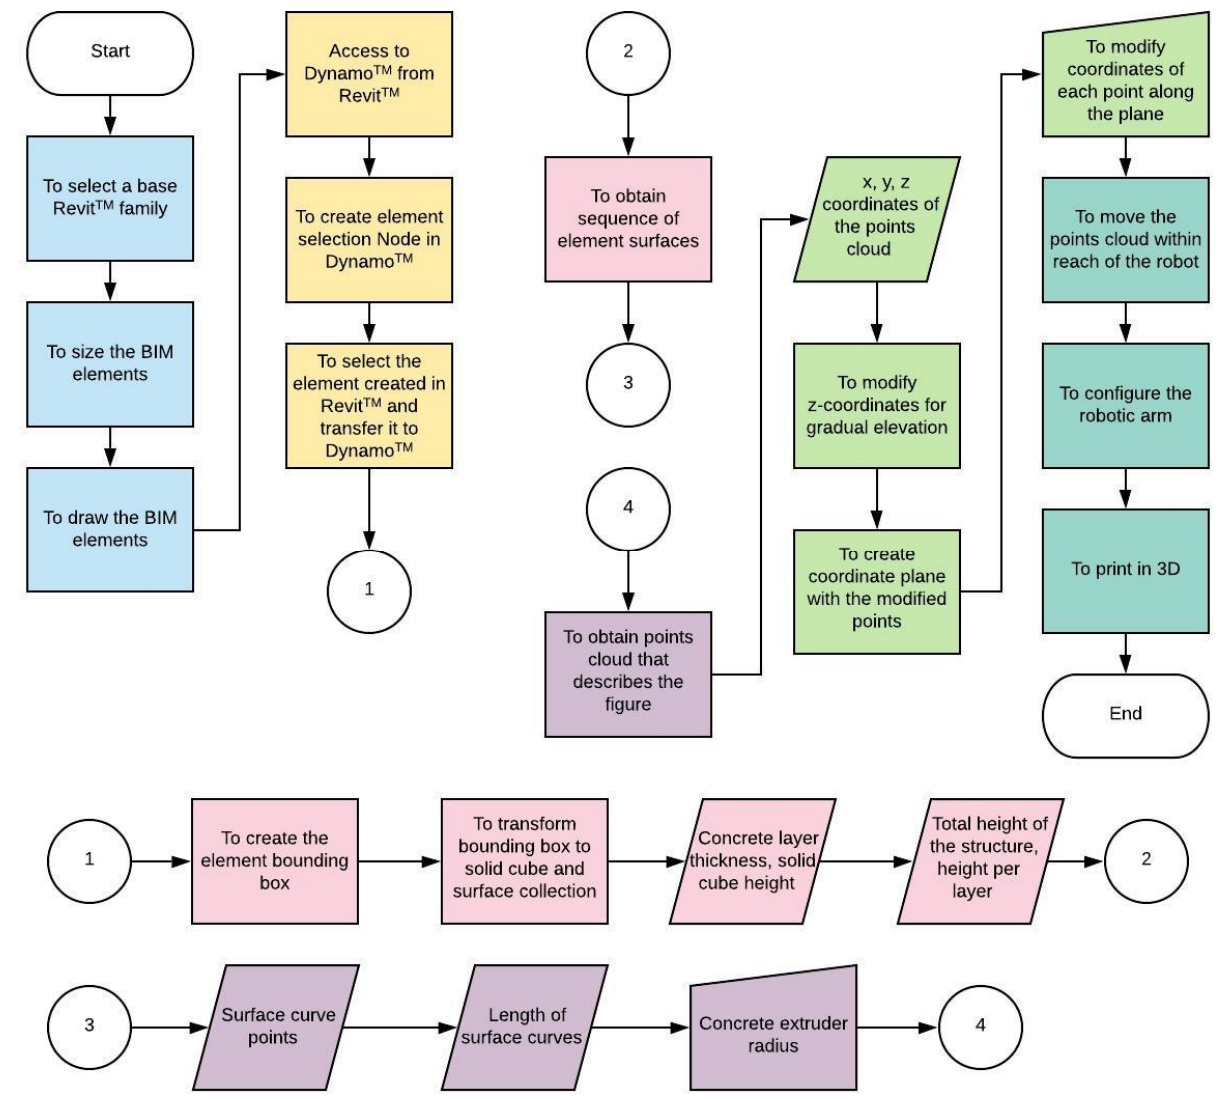
Figure 5. Flowchart for the printing of a construction element. Design of a construction element in Revit TM , described in Section 4.1.1. Exporting a construction element from Revit TM to Dynamo TM , described in Section 4.1.2. Control code of the printing process with the robotic arm, described in Section 4.1.3. Calculations and printing costs, described in Section 4.1.4.